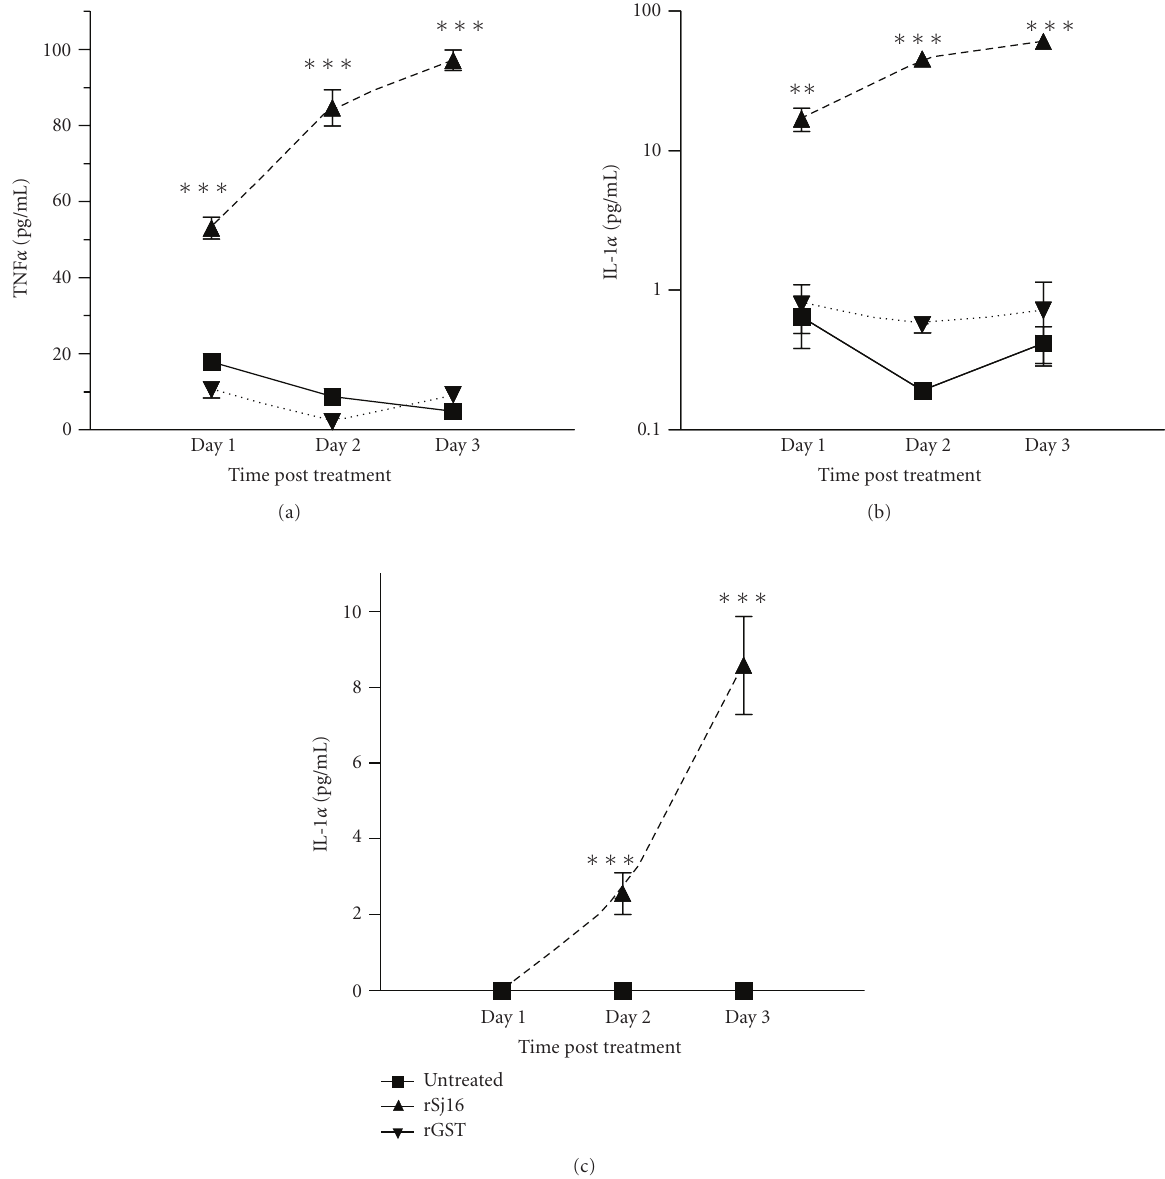
Figure 6: E ff ect of rSj16 on IL -1 α , IL -1 β , and TNF - α production from WEHI-3B JCS cells. WEHI-3B JCS cells were treated with 0.5 μ g/ml rSj16 ( rSj16 ), 0.5 μ g/ml rGST ( rGST ), or medium alone ( untreated ), and then the culture supernatants were collected at di ff erent time as indicated for the detection of TNF- α (a), IL-1 α (b), and IL-1 β (c) by Sandwich ELISA. Values represent mean ± SEM of three independent experiments. ∗∗∗ P < . 001; ∗∗ P < . 01, as compared with that of untreated